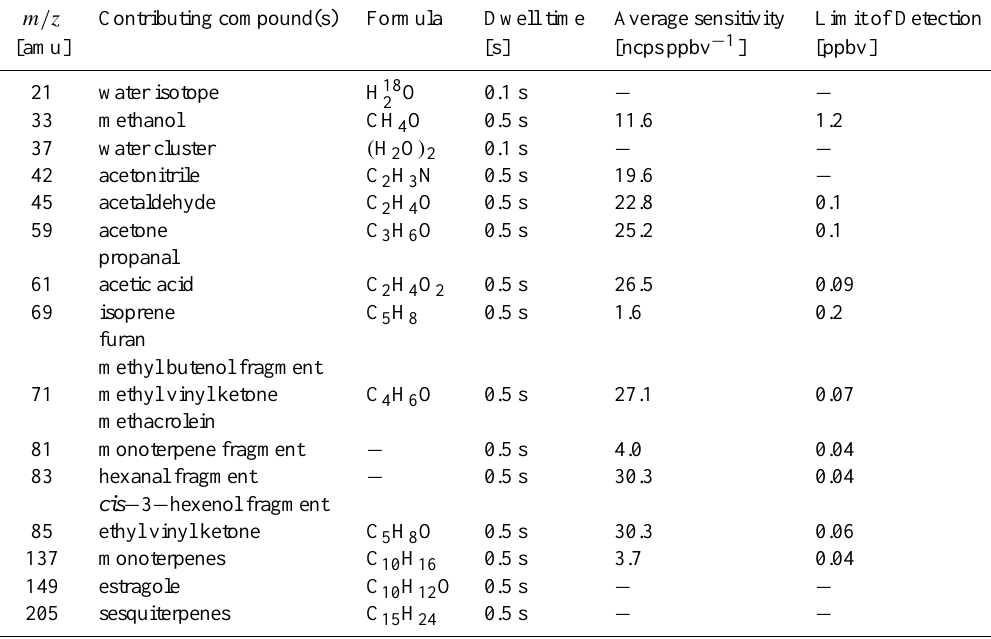
Table 1. List of compounds measured during the OP3 campaigns, including their formula, dwell time, average sensitivity and detec- tion limit. Detection limits were calculated based on the signal to noise ratio of measured ion counts following Karl et al. (2003) (LOD=2 × σ background